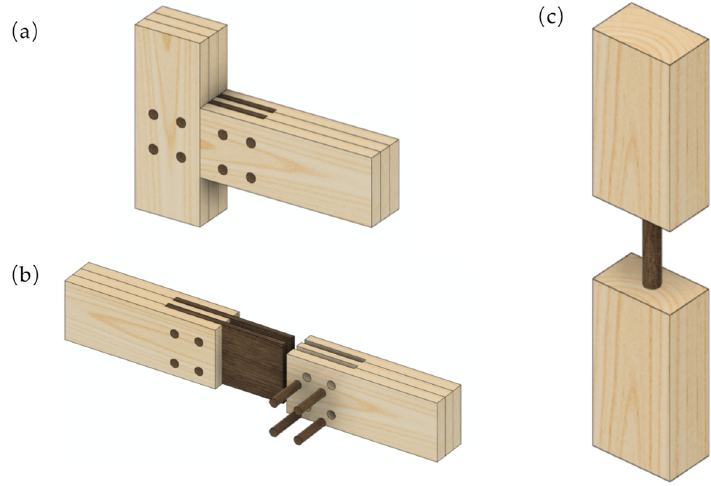
Figure 12. Examples of applications using the densified wood as connection materials: ( a ) beam– column connection, ( b ) beam–beam connection, and ( c ) glued-in-rod joint.